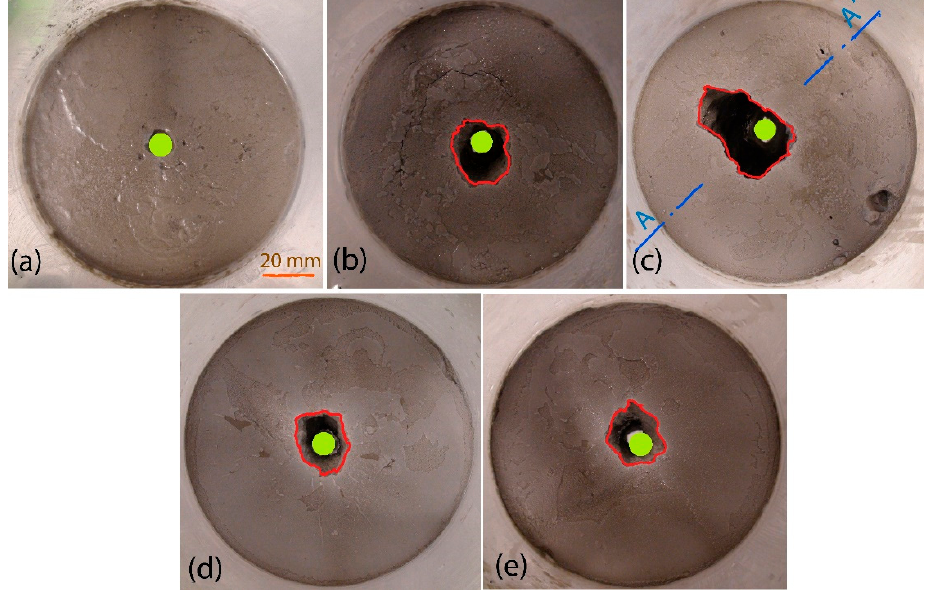
Figure 6. Inlet side of specimens with Bentovet K: ( a ) standard grout mixture K1 before the test; ( b ) grout mixture K1 after the test—WL = 4.7%; ( c ) grout mixture K2 after the test—WL = 11.4%; ( d ) grout mixture K3 after the test—WL = 2.1%; ( e ) grout mixture K4 after the test—WL = 5.0% (the edge of the failure area in red, the initial hole in green).